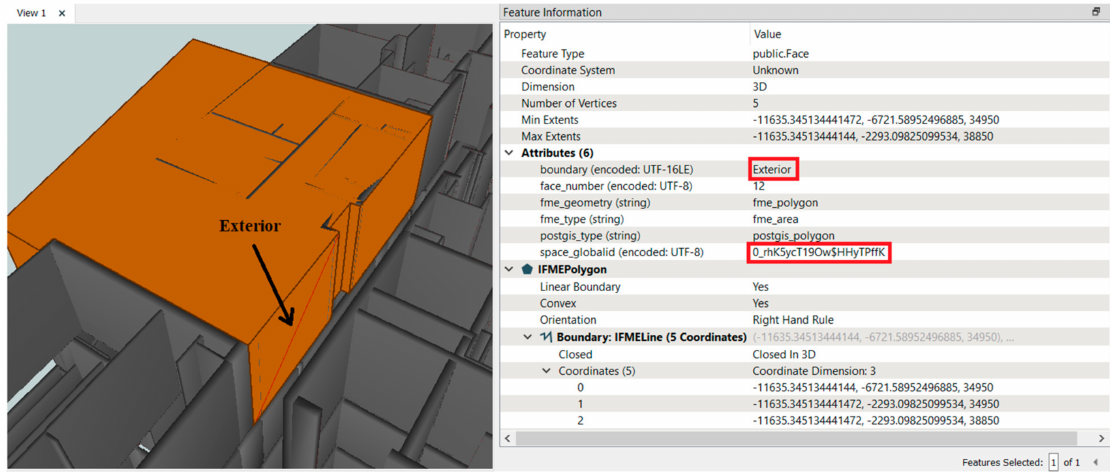
Figure 24. An Exterior boundary for the lot with the Globalid: 0_rhK5ycT19Ow$HhyTPffK associated with the wall.